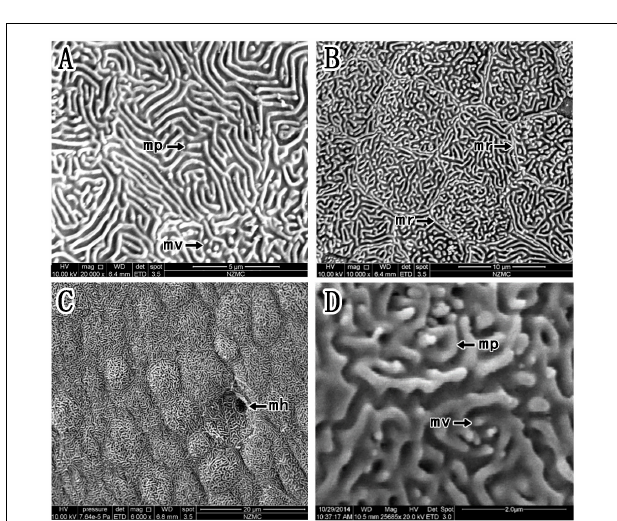
FIGURE 5 | (A–D) Corneal epithelial cells of P. magnuspinnatus under a scanning electron microscope. The type and microstructure of the epithelial cells are shown (mp, microplicae; mv, microvilli; mh, microholes; mr, microridges).